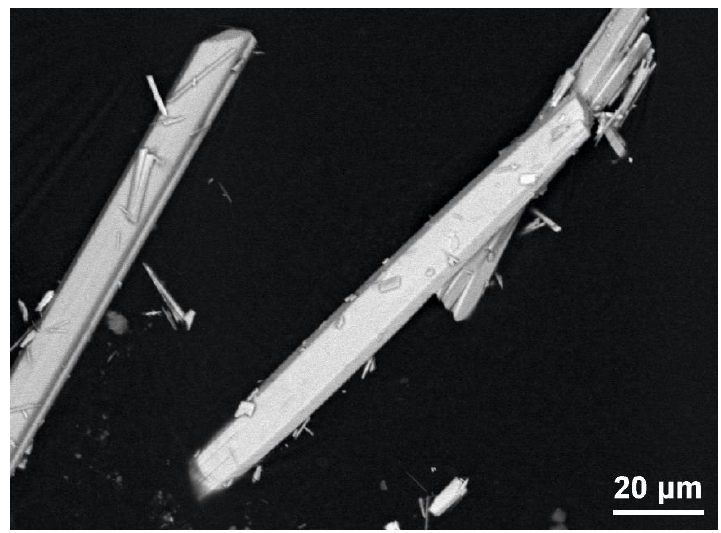
Figure 1. The back-scattered electron image of the idiomorphic crystals of Co 3 (AsO 4 ) 0.5+x (HAsO 4 ) 2−x (H 2 AsO 4 ) 0.5+x [(H,□) 0.5 (H 2 O,H 3 O) 0.5 ] 2x+ .